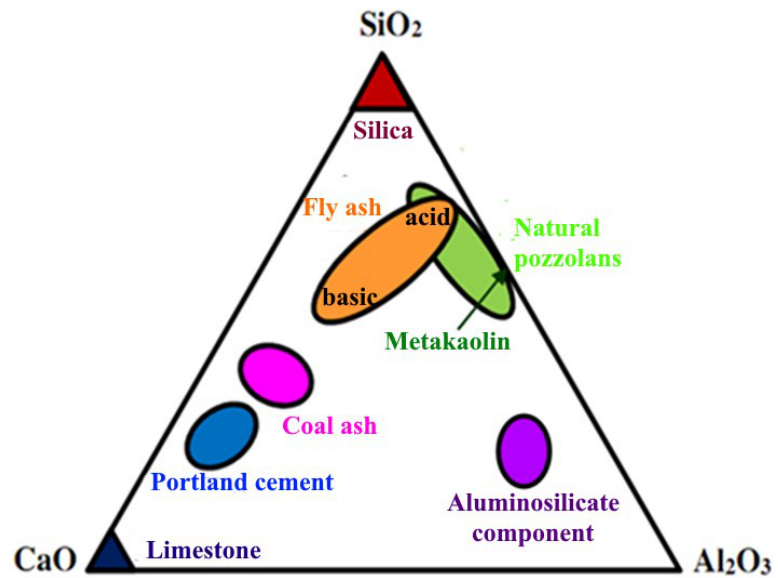
Figure 17. Place of the obtained aluminosilicate component in the “ CaO-SiO 2 -Al 2 O 3 ” system. One can see an increase in the amorphism of the aluminosilicate component com- pared to the initial coal ash (Figure 18), which will positively affect the reactivity.